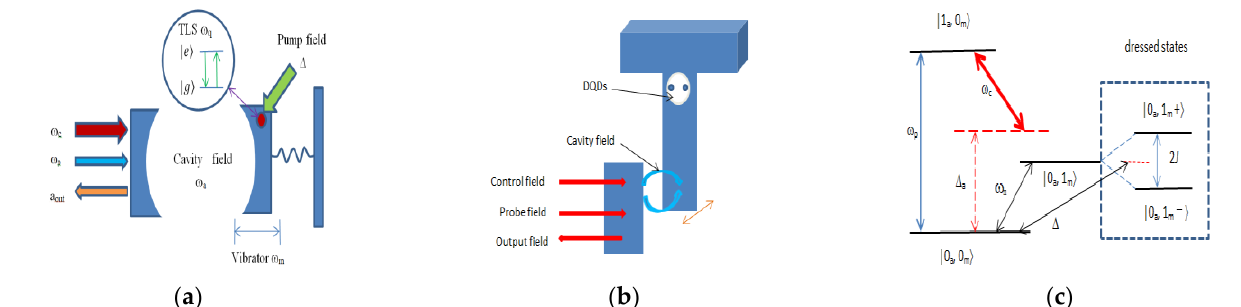
Figure 1. ( a ) Principle diagram of the HOMS. The optical cavity is coupled to a mechanical resonator, which is also coupled to a two-level system (TLS). The cavity is pumped by a control optical field with frequency 𝜔 𝑐 and is driven by a weak probe field with frequency 𝜔 𝑝 , and 𝑎 𝑜𝑢𝑡 is the output of the cavity field. The TLS is driven by a driving field with frequency 𝛥 = 𝜔 𝑝 − 𝜔 𝑐 . ( b ) Structure sketch map of the HOMS. The movable mirror can be realized by a cantilever, and the artificial TLS can be realized by double quantum dots (DQDs). ( c ) Energy level diagram of the HOMS with single-photon and single-phonon excitation. 𝛥 𝑎 = 𝜔 𝑎 − 𝜔 𝑐 . |0 𝑎 ,0 𝑚 ⟩ and |1 𝑎 ,0 𝑚 ⟩ represent the states of the system with 0 or 1 particle, a and m denote the cavity and mechanical modes, respectively. |0 𝑎 , 1 𝑚 ±⟩ are the dressed states due to the coupling between the TLS and the mechanical mode. |0 𝑎 ,1 𝑚 ±⟩ = (|0 𝑎 , 1 𝑚 ,𝑒⟩ ± |0 𝑎 ,1 𝑚 ,𝑔⟩)/√2 .